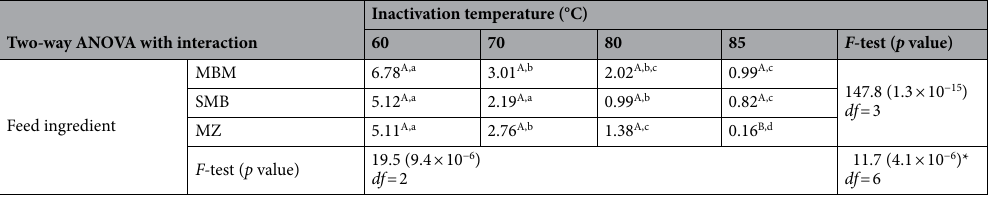
Table 3. Comparing the mean D T (min) of ASFV in 3 feed ingredients of 4 inactivation temperatures. In the column-wise comparison, mean D